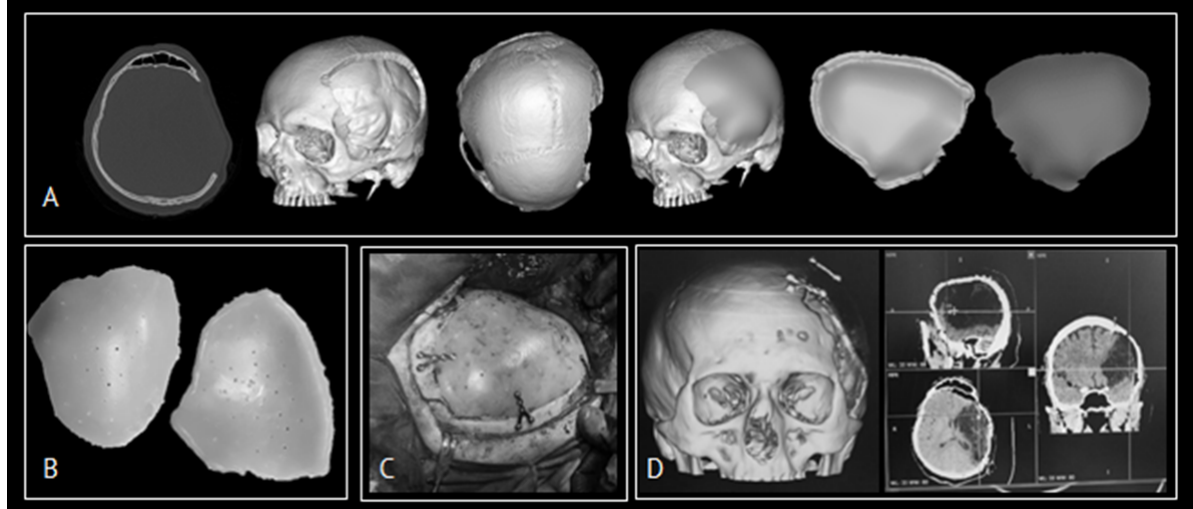
Figure 4 . A - patient with SoT, preoperative virtual surgical planning and PSI modeling., B - personalized cranial plate from PMMA., C - intraoperative aspect of cranioplasty intervention., D - postoperative CT images with bone